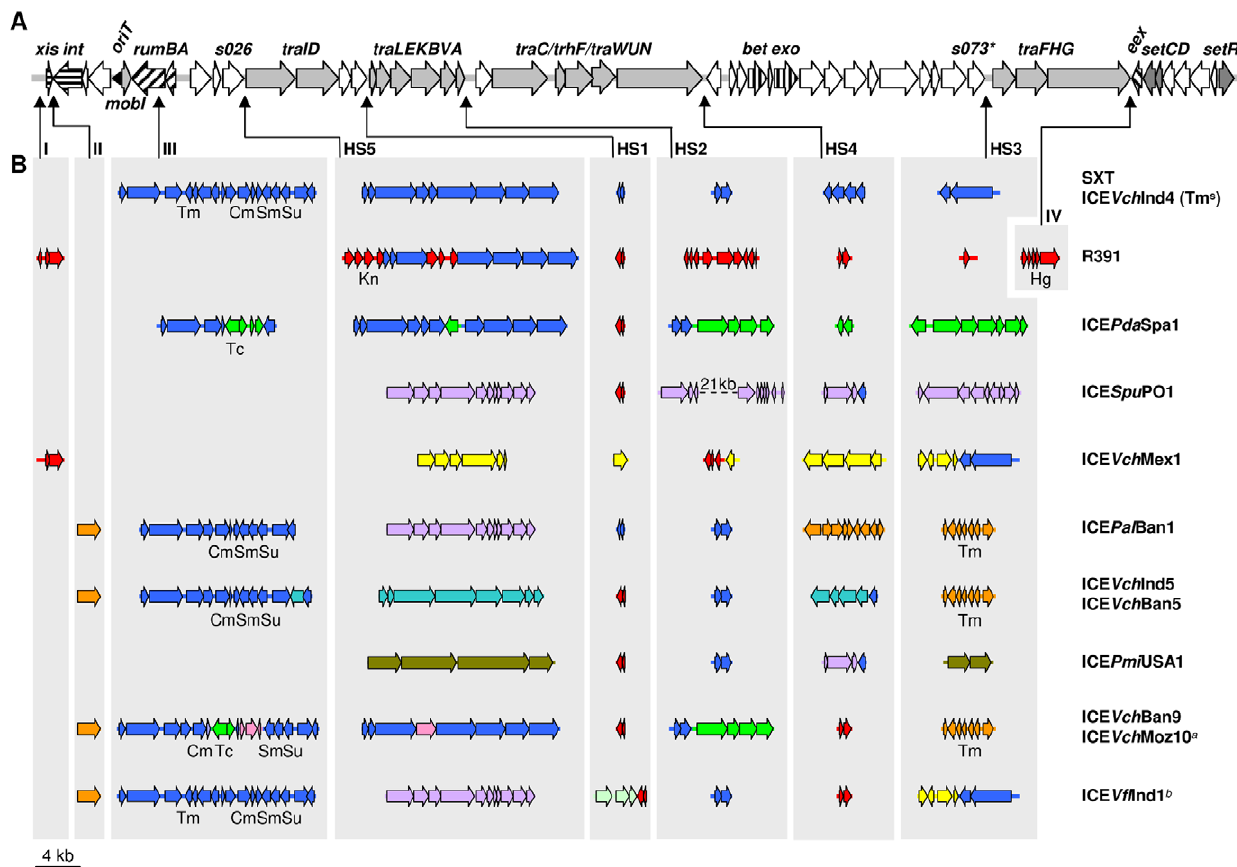
Figure 2. Structure of the genomes of 13 SXT/R391 ICEs. (A) The upper line represents the set of core genes (thick arrows) and sequences common to all 13 SXT/R391 genomes analyzed. Hatched ORFs indicate genes involved in site-specific excision and integration ( xis and int ), error- prone DNA repair ( rumAB ), DNA recombination ( bet and exo ) or entry exclusion ( eex ). Dark gray ORFs correspond to genes involved in regulation ( setCDR ). Light gray ORFs represent genes encoding the conjugative transfer machinery, and white ORFs represent genes of unknown function. (B) Variable ICE regions are shown with colors according to the elements in which they were originally described SXT (blue), R391 (red), ICE Pda Spa1 (green), ICE Spu PO1 (purple), ICE Vch Mex1 (yellow), ICE Pal Ban1 (orange), ICE Vch Ind5 (turquoise), ICE Pmi USA1 (olive), ICE Vch Ban9 (pink), ICE Vfl Ind1 (light green). Thin arrows indicate the sites of insertion for each variable region and HS1–HS5 represent hotspots 1–5. Roman numerals indicate variable regions not considered true hotspots. Cm, chloramphenicol; Hg, mercury; Kn, kanamycin; Sm, streptomycin; Su, sulfamethoxazole; Tc, tetracycline; Tm, trimethoprim. * indicates that s073 is absent from ICE Pda Spa1. a ICE Vch Moz10, which lacks dfrA1 in the integron structure, does not confer resistance to Tm. b The purple gene content of ICE Vfl Ind1 was deduced from partial sequencing, PCR analysis and comparison with ICE Spu PO1.